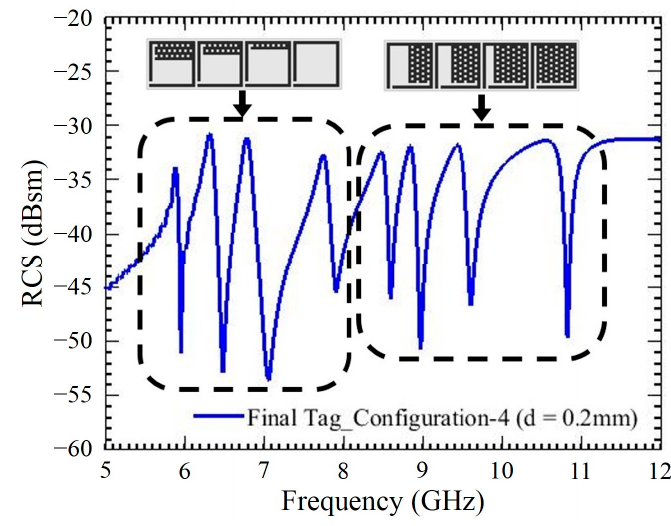
Figure 11. Simulated RCS response of the final proposed tag.